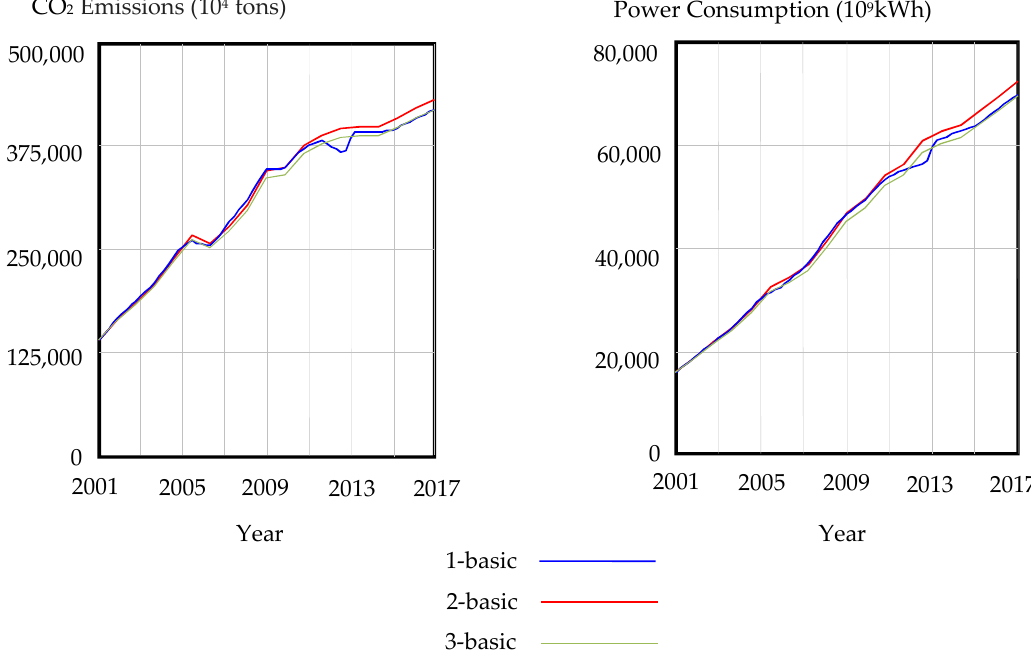
Figure 8. Results of the system operation test of the SD model.